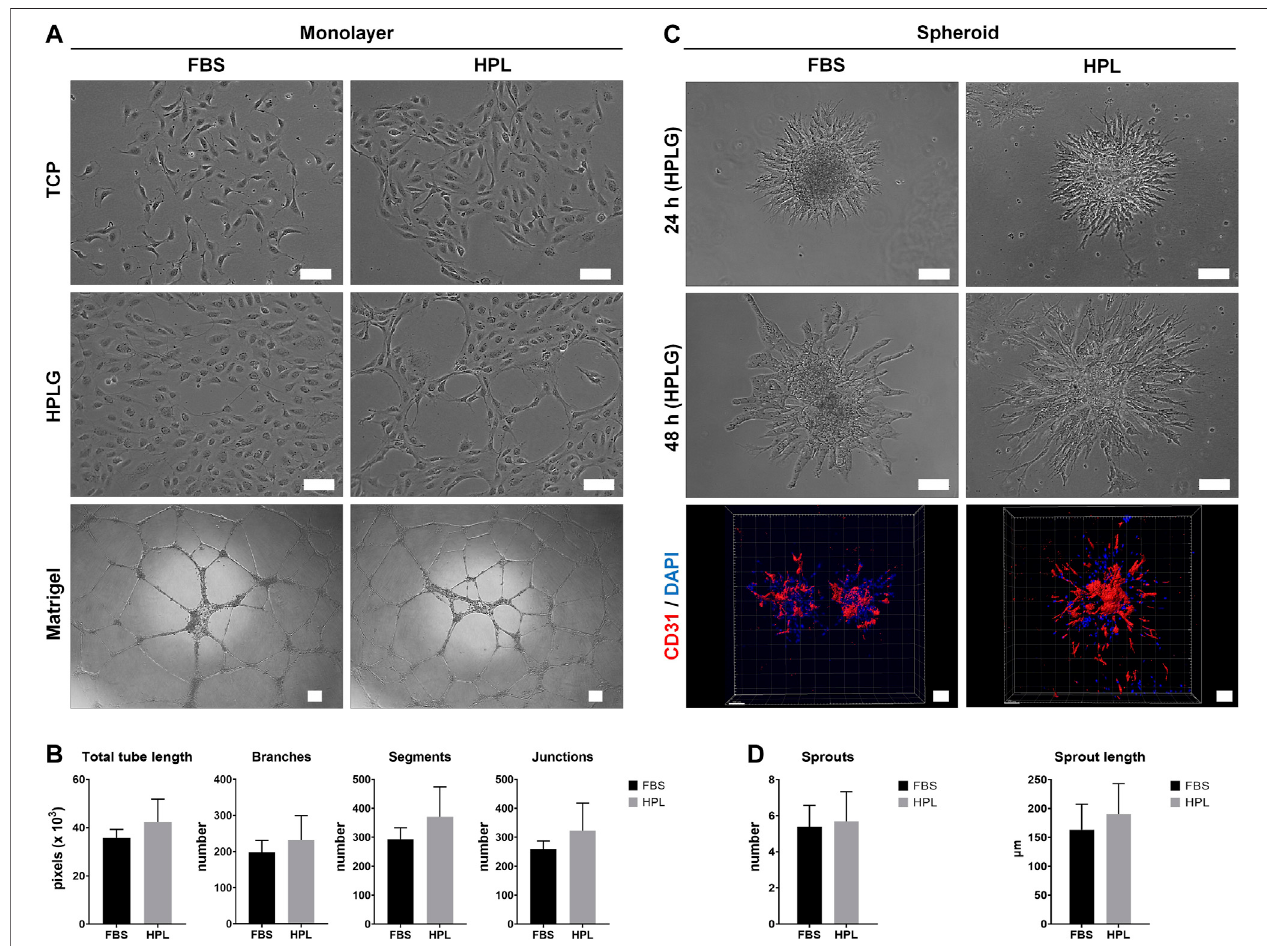
FIGURE 1 | Xeno-free HUVEC culture in HPL. (A) Comparison of HUVEC morphology in HPL and FBS on tissue culture plastic (TCP) and HPLG, and correspondingtube formation onMatrigelafter 24 h; scale bars 100 µm. (B) Analysisoftube formationparameters;data represent means ± SD (n (cid:2) 3). (C) Comparison of in vitro sprouting by HUVEC spheroids in HPL and FBS after 24 and 48 h in HPLG; IF staining for CD31 (HUVEC, red) and DAPI (nuclei, blue) in 48 h-spheroids; scale bars 100 µm. (D) Analysis of sprout formation parameters; data represent means ± SD (n (cid:2) 3 or more).